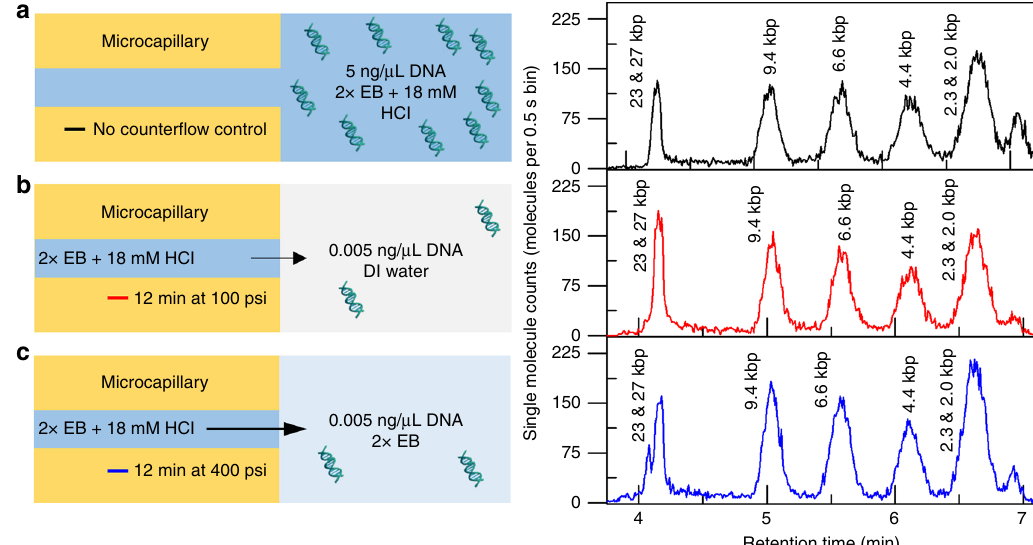
Fig. 7 Effect of reservoir buffer solution on MRT preconcentration. A schematic describing the experimental preconcentration conditions is shown on the left, and the single-molecule chromatogram after separation is shown on the right. In all conditions, 2× EB + 18 mM HCl was used as the running buffer. a Control separation of λ DNA Hin dIII digest without preconcentration or a buffer mismatch: the reservoir buffer is the same as the running buffer and no counter fl ow is applied. b Counter fl ow at 100 psi for 12 min into reservoir buffer containing Hin dIII digested λ DNA in DI water. The DNA, originally suspended at 0.005 ng/ μ L concentrates 1000-fold prior to separation. c A similar 1000-fold concentration factor is achieved with the reservoir